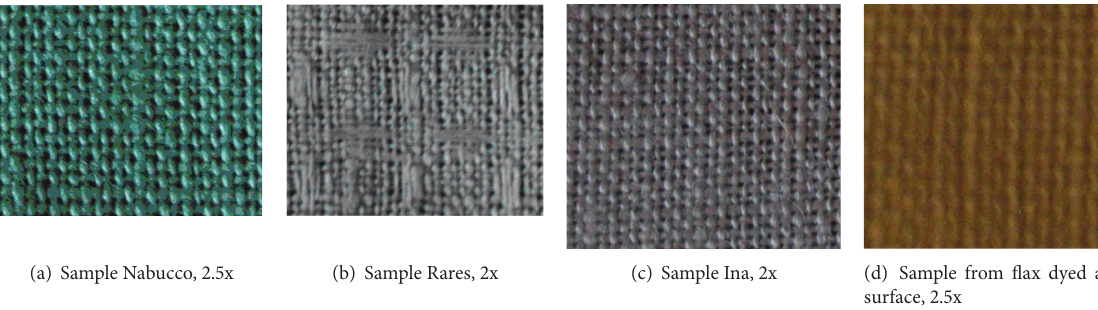
Figure 5: Images of weaves from